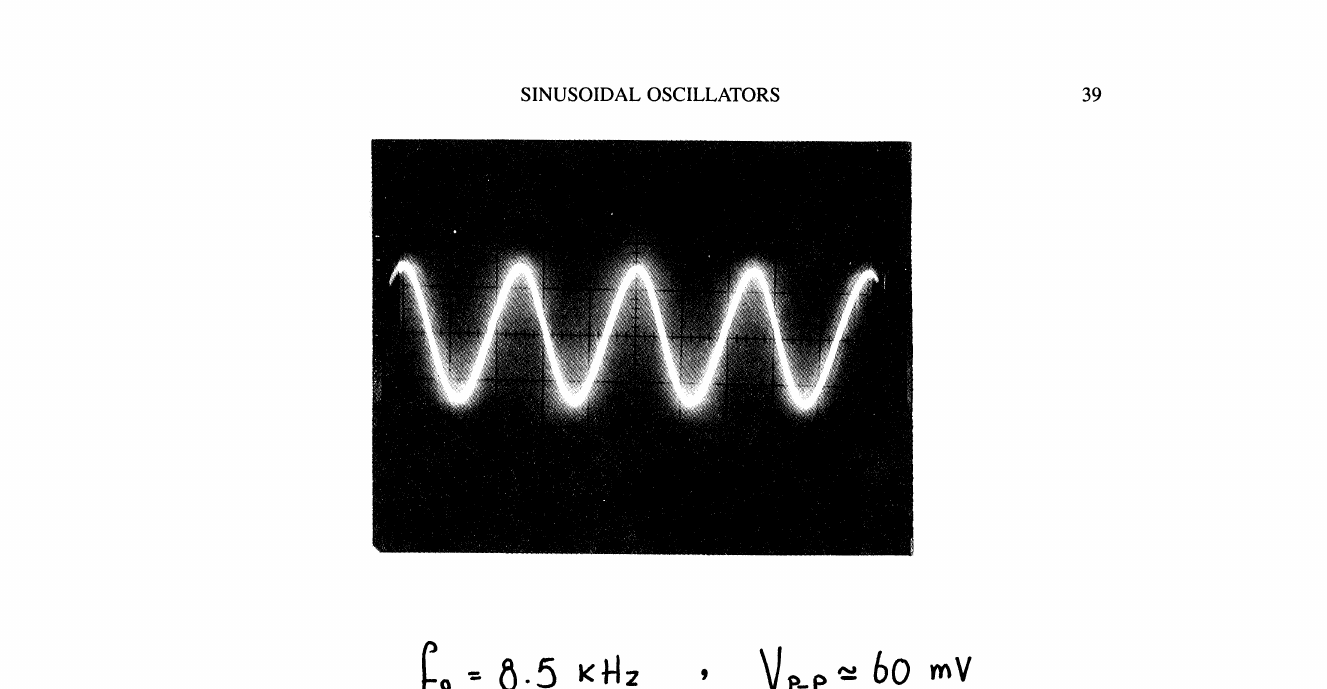
FIGURE 6 Typical output waveform obtained from Fig. 4(a) with: C2 0, IB1 IBm. 0.2